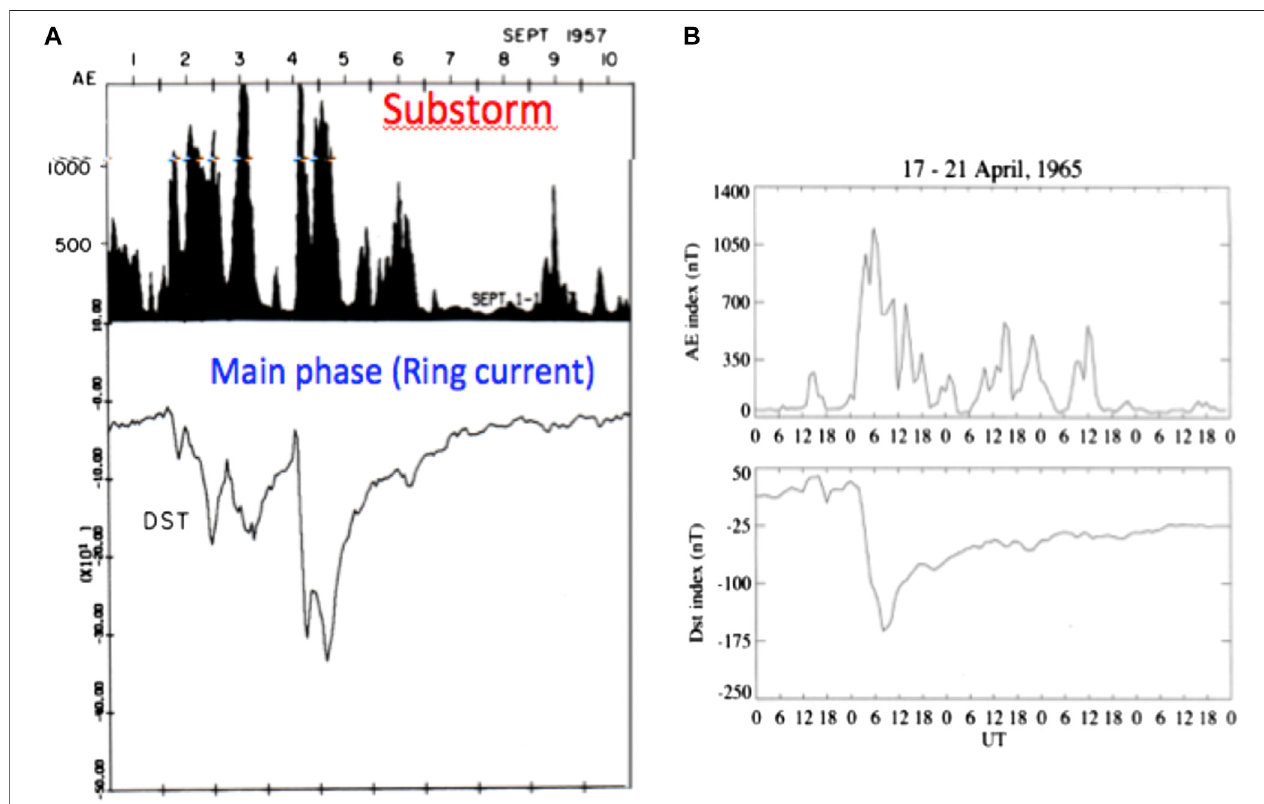
FIGURE 4 | (A) The fi rst fi gure which combines both the AE and Dst indices together. (B) Another example made much